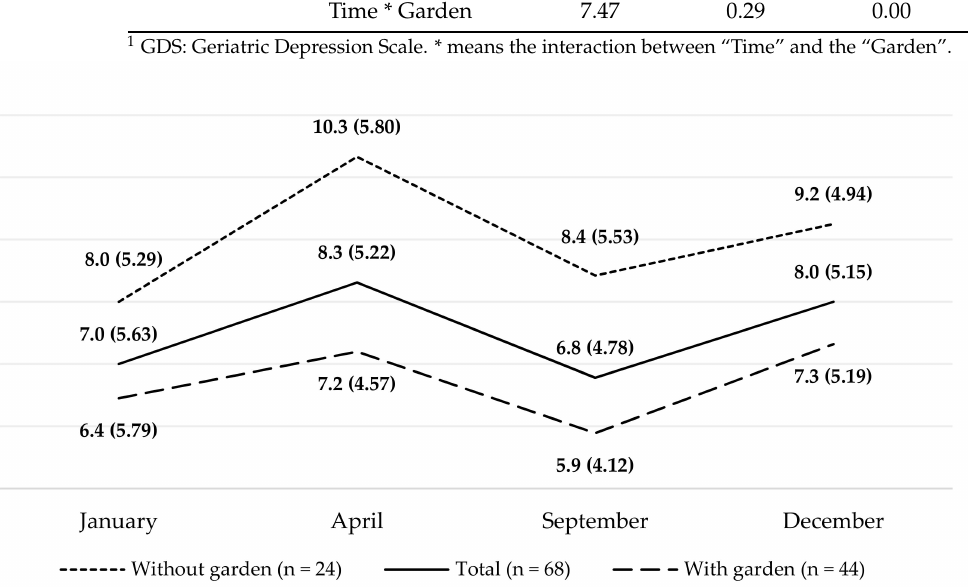
Figure 2. Intensification of depression symptoms at subsequent measurement points in the entire study group and groups with or without access to a